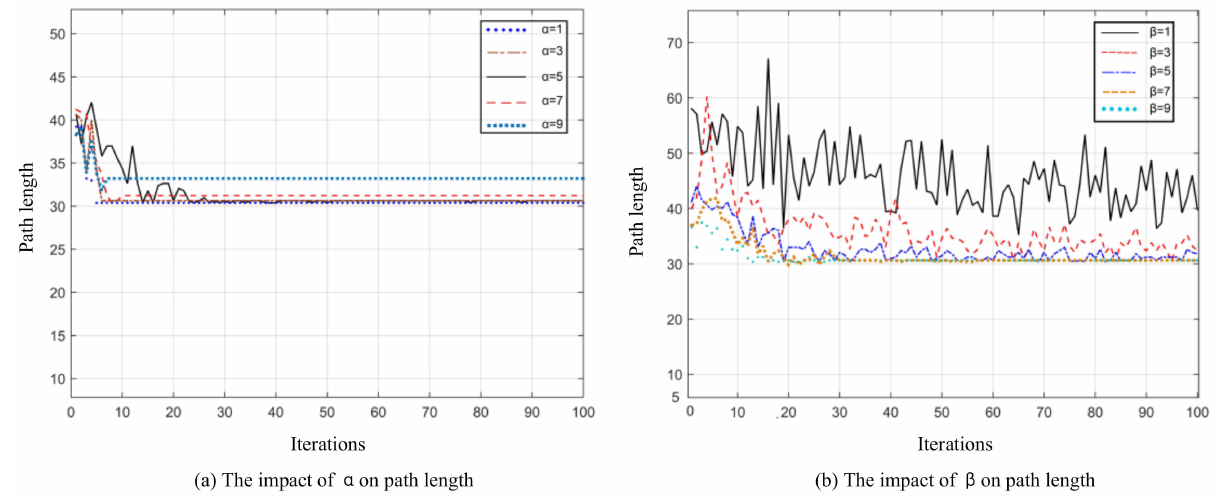
Figure 2. The impact of two fuzzy controller output variables on the path length. The fuzzy controller uses the Mamdani inference method. The fuzzy inference flow chart is shown in Figure 3. The function of the fuzzy input and output variable is shown in Figure 4.